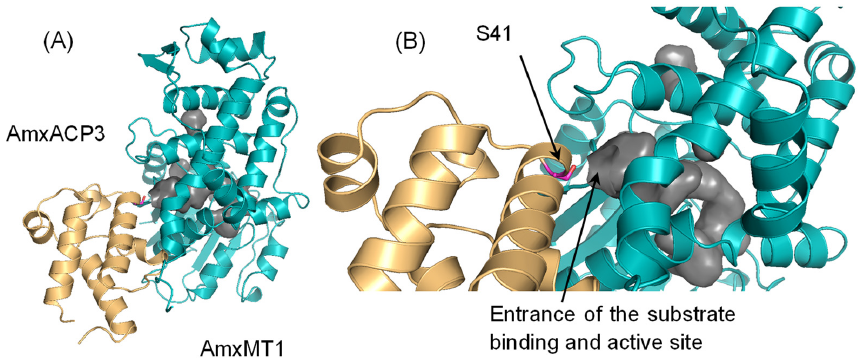
Figure 4. AmxACP3-AmxMT1 complex model ( A ) AmxACP3-AmxMT1 from Brocadia fulgida binary complex model predicted by AlphaFold. AmxACP3 and AmxMT1 are shown in light orange and teal, respectively. Ser41 of AmxACP3, to which the substrate would be connected, is shown as a magenta stick model. A substrate binding pocket of AmxMT1 is shown in gray as a surface model. ( B ) Close-up view of the AmxACP3 and AmxMT1 interface region in the model complex.